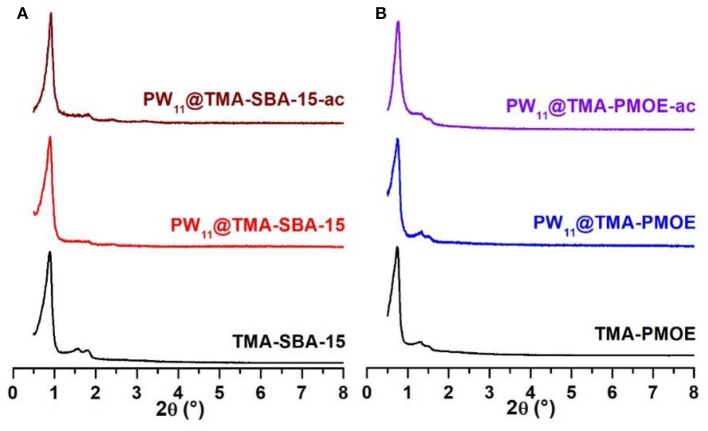
Powder XRD patterns of (A) TMA-SBA-15 and (B) TMA-PMOE composites with PW11 (ac stands for after catalysis).